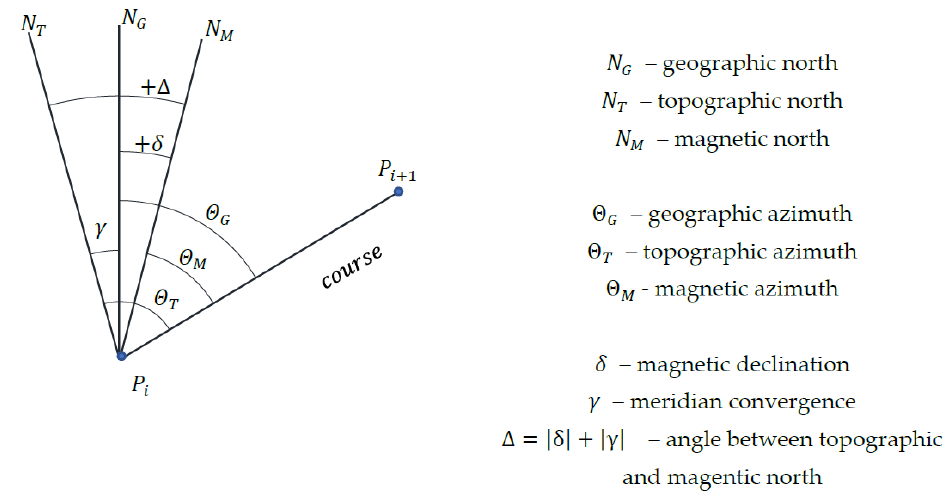
Figure 11. Azimuth definition.